Question: Summarize what this figure shows in one sentence.
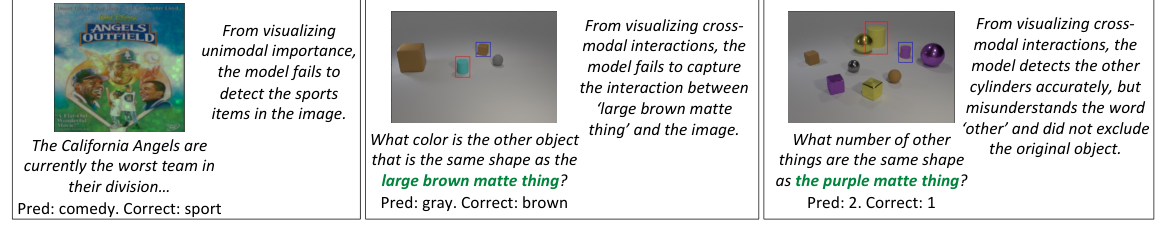
Answer: 5: Examples of human-annotated error analysis using MULTIVIZ on multimodal models. Using all stages provided in MULTIVIZ enables fine-grained classification of model errors (e.g., errors in unimodal processing, cross-modal interactions, and predictions) for targeted debugging.